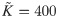
Stochastic Allee and collapse thresholds.Stochastic Allee and collapse thresholds as functions of control intensity for different levels of noise and for different strengths of the Allee effect in the range of bistable dynamics (A to D) and in the range of essential extinction (E to H). Calculations are based on Models (1) and (2) with r = 4.5 and K˜=400. For a given initial population size, the probability of extinction has been obtained for the first 100 generations and over 5000 replicates. The right-hand side panels show stochastic collapse threshold only for ATH since they exist under ALC only for extremely small intensities.